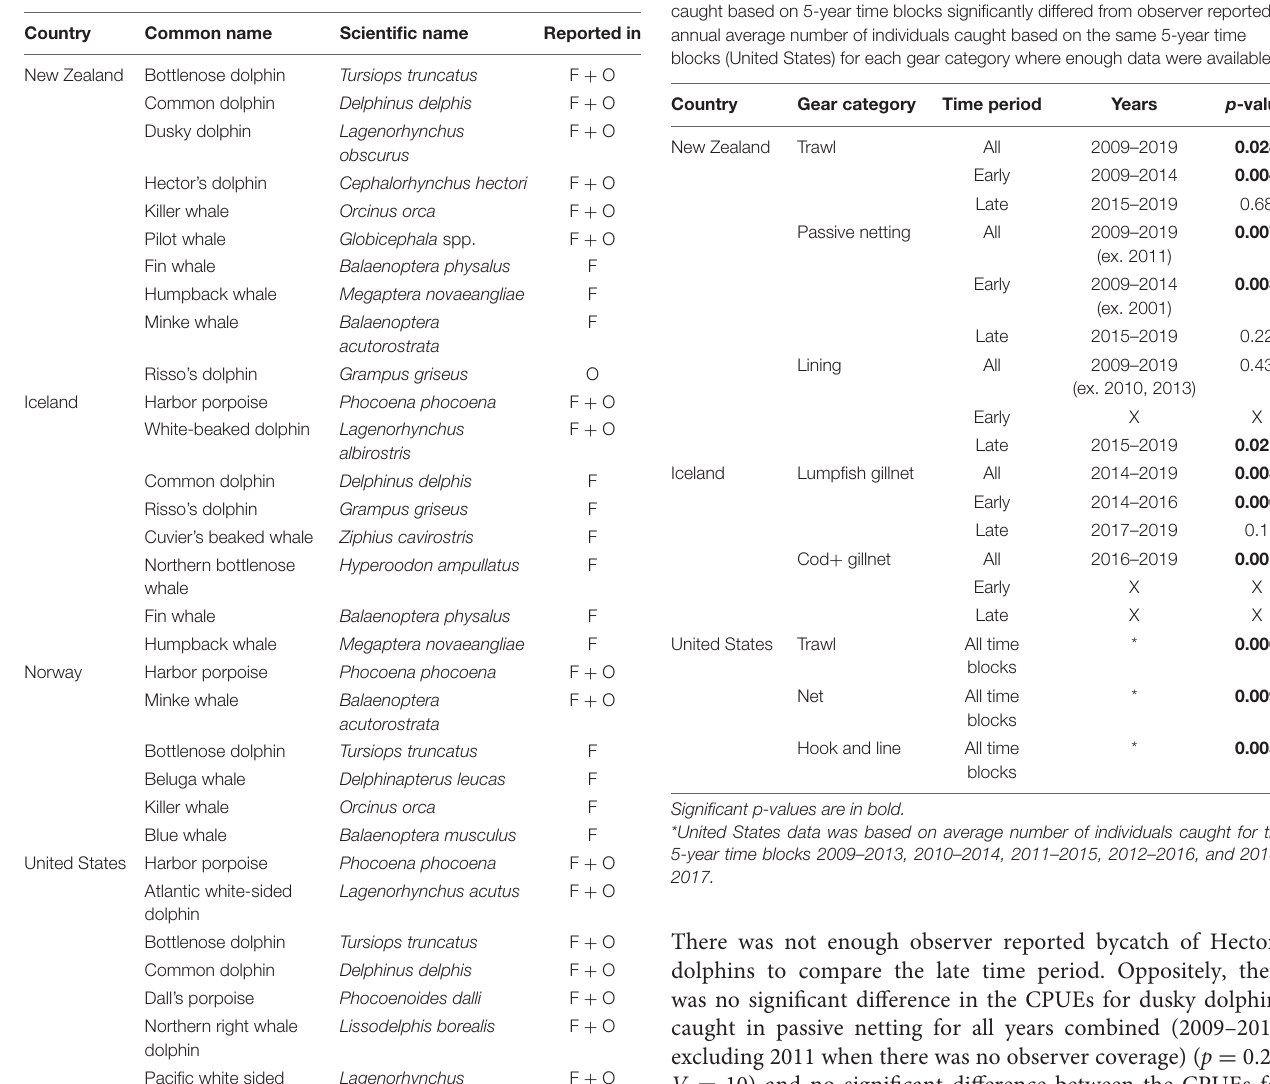
TABLE 3 | p -value results of paired t -test/Wilcoxon tests determining if fisher reported CPUE was significantly lower than observer reported